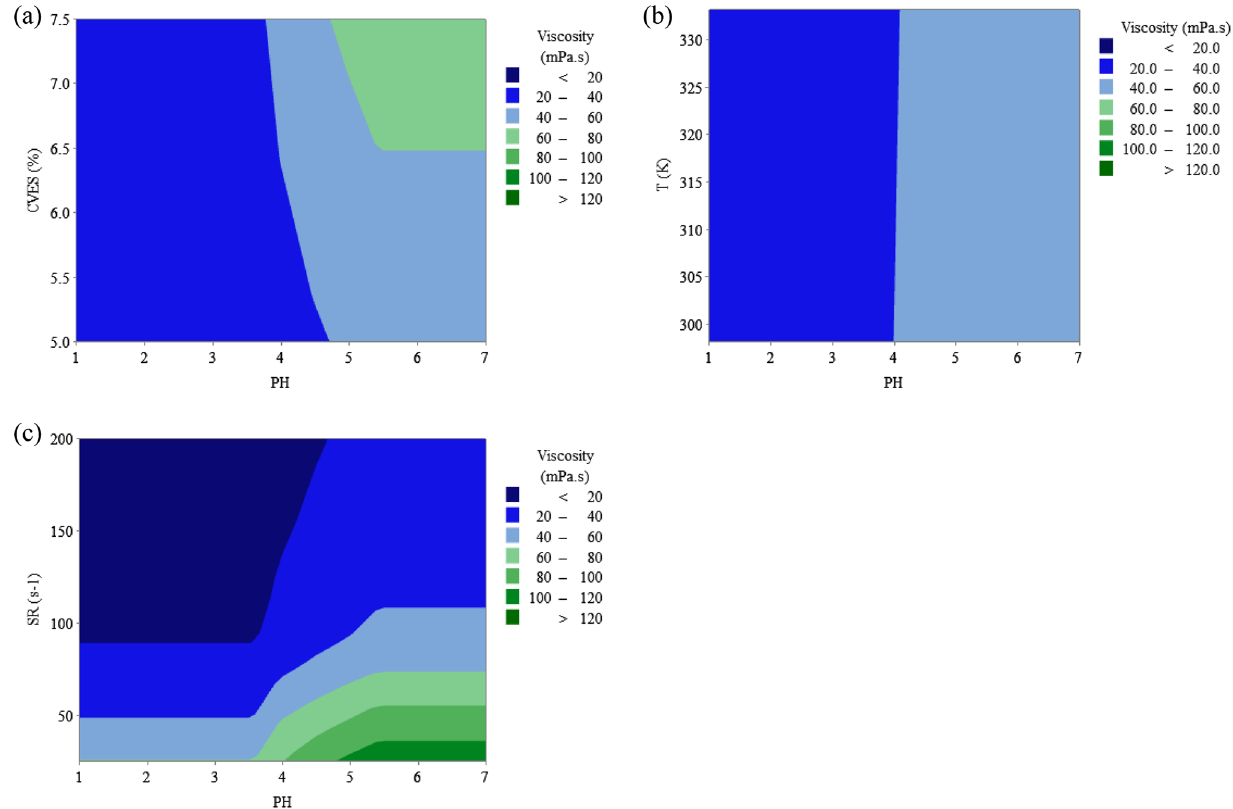
Fig. 3 The changes of the VES viscosity with different input parameters of VES concentration (C